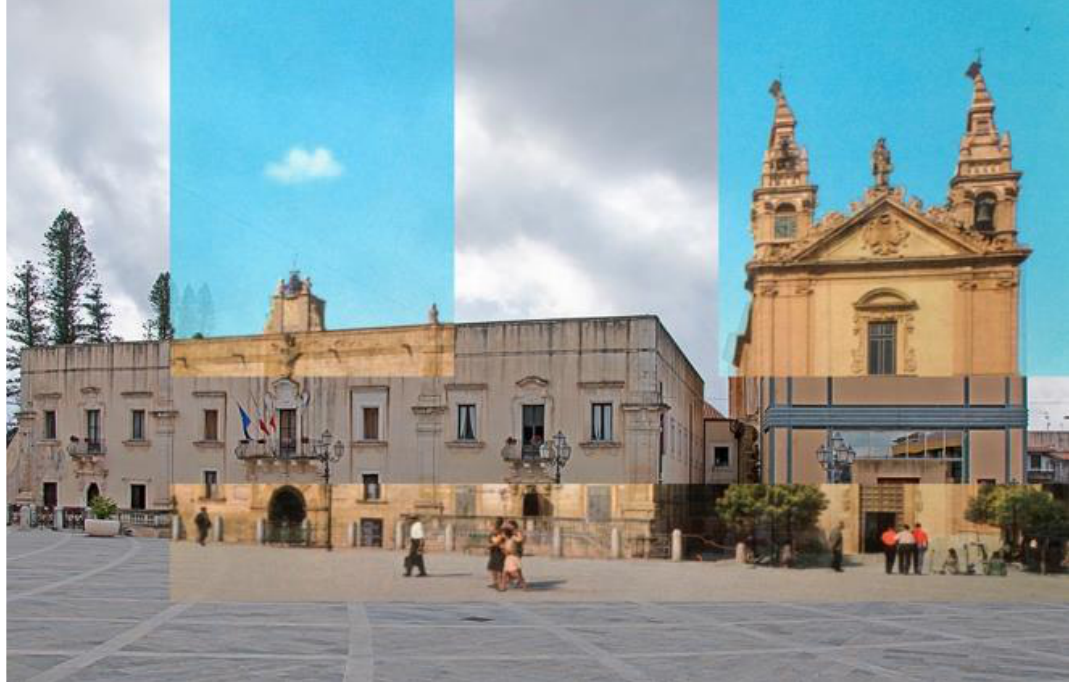
Figure 16. Re- photographic overlap between Cathedral and Palazzo Cutò (Photo: Maggio for L’Ora, Archivio de L’Ora, Biblioteca Regionale Siciliana “Alberto Bombace”, Palermo) and Piazza Giacomo Matteotti (Photo by the authors, Santa Margherita di Belìce 2020).